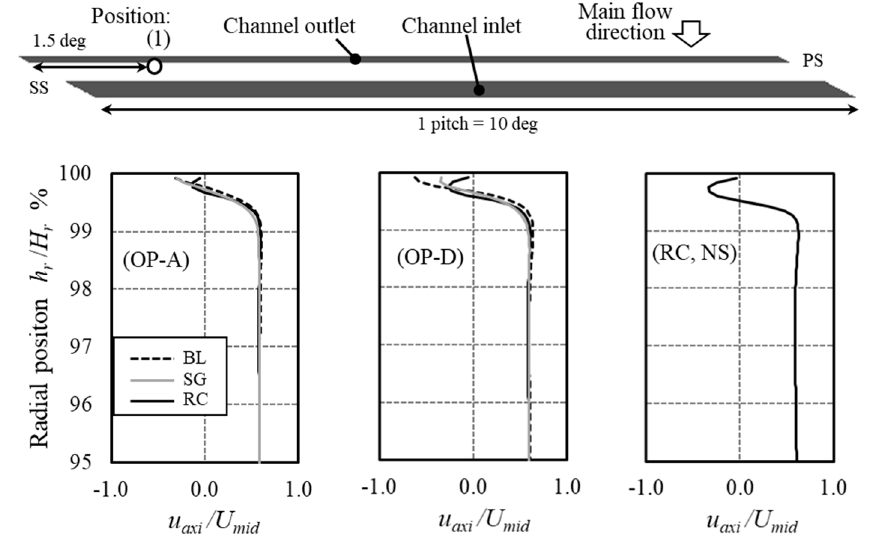
Figure 11. Radial profiles of Reynolds-Averaged Navier–Stokes axial velocity predictions near the casing wall showing the change with the rotor loading. These radial profiles were extracted at the constant pitch-wise angle of Position (1) shown in the sketch above the graphs.